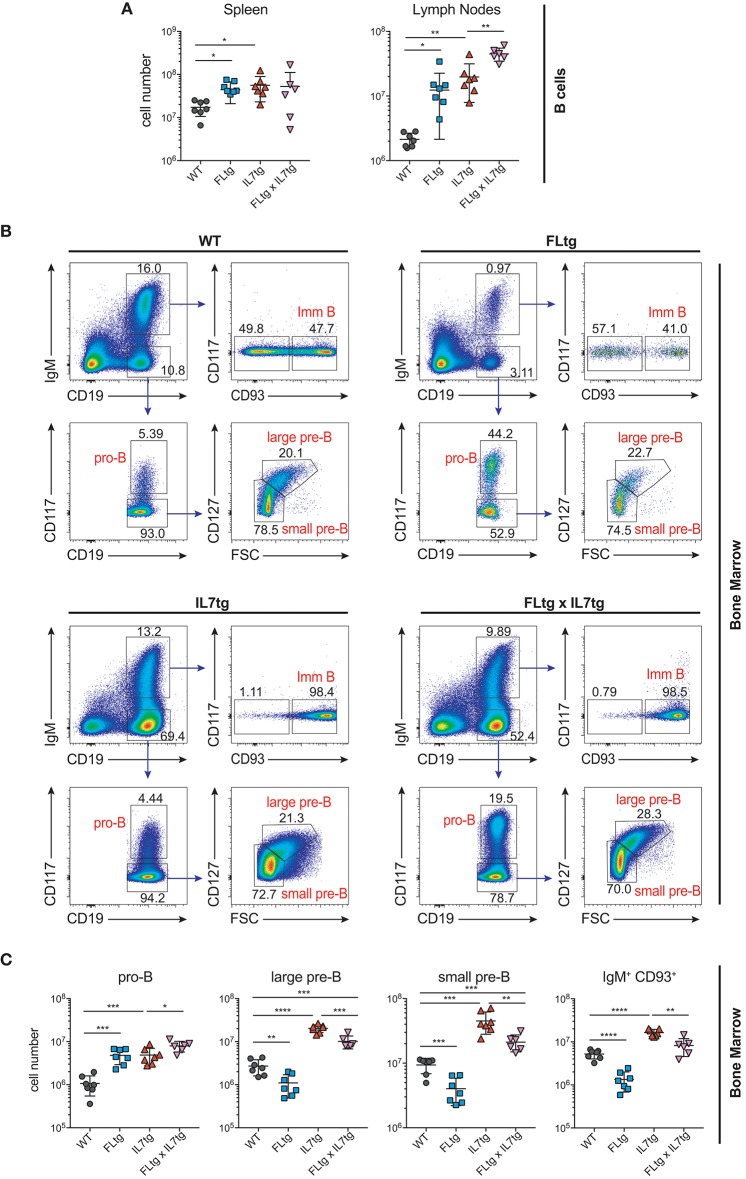
Expansion of B cell populations in lymphoid organs of FLtgxIL7tg mice. (A) Numbers of IgM+CD93− mature recirculating B cells in the spleen (left) and lymph nodes (axillary and inguinal) (right) of WT, FLtg, IL7tg, and FLtgxIL7tg mice. (B) Representative FACS plots for the identification of B cell progenitor stages in the bone marrow of WT (upper left), FLtg (upper right), IL7tg (lower left), and FLtgxIL7tg (lower right) mice. Gate numbers indicate frequencies of parent gate. (C) Numbers of pro-B (CD19+IgM−CD117+), large pre-B (CD19+IgM−CD117−CD127+FSClarge), small pre-B (CD19+IgM−CD117−CD127−FSCsmall) and immature B (CD19+IgM+CD93+) in the bone marrow of WT, FLtg, IL7tg, and FLtgxIL7tg mice. B cell populations were identified as indicated in B. *p < 0.05, **p < 0.01, ***p < 0.001, ****p < 0.0001. Error bars indicate standard deviation.